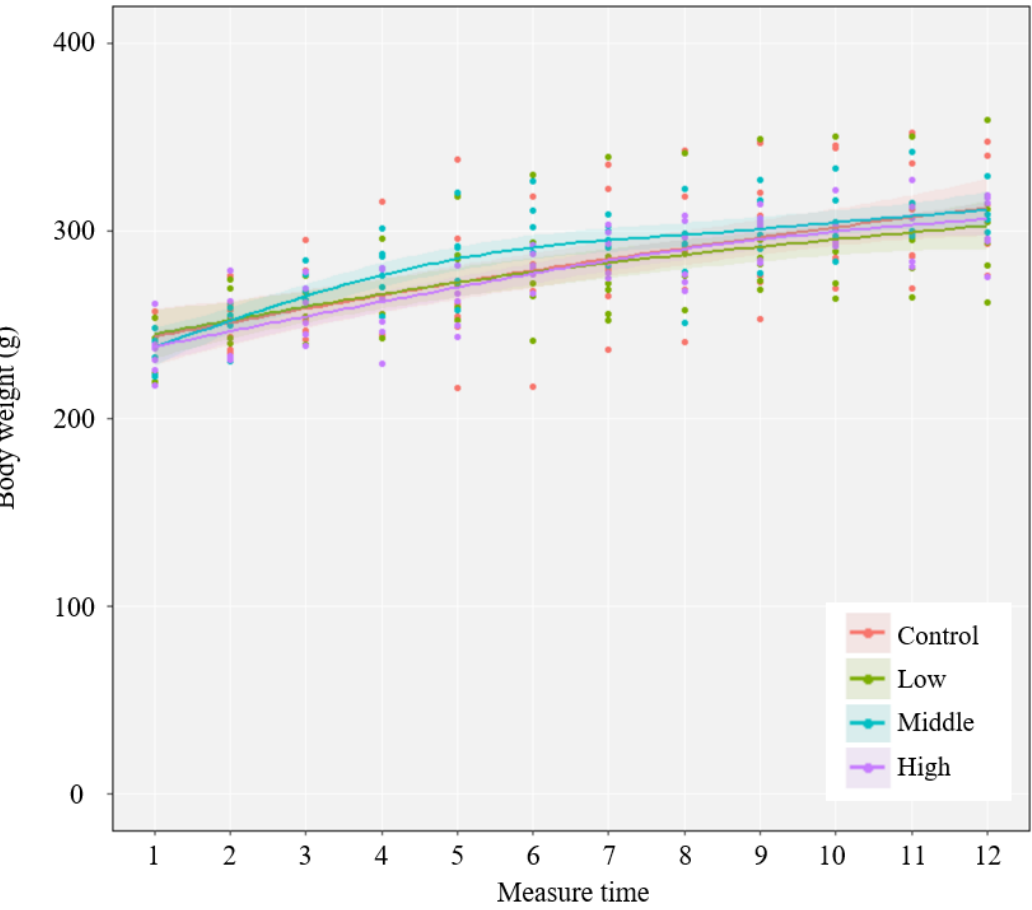
Figure 2. The effect of rare earth elements’ administration on body weight changes of rats among the four administration groups, i.e., control, low, middle, and high. The change curve was fitted using a non-linear regression model with R software. The shaded area represents the 95% confidence level.